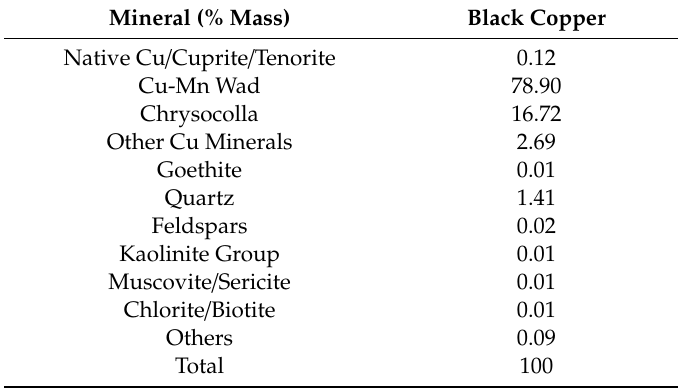
Table 2. The mineralogical composition of the black copper samples as determined by